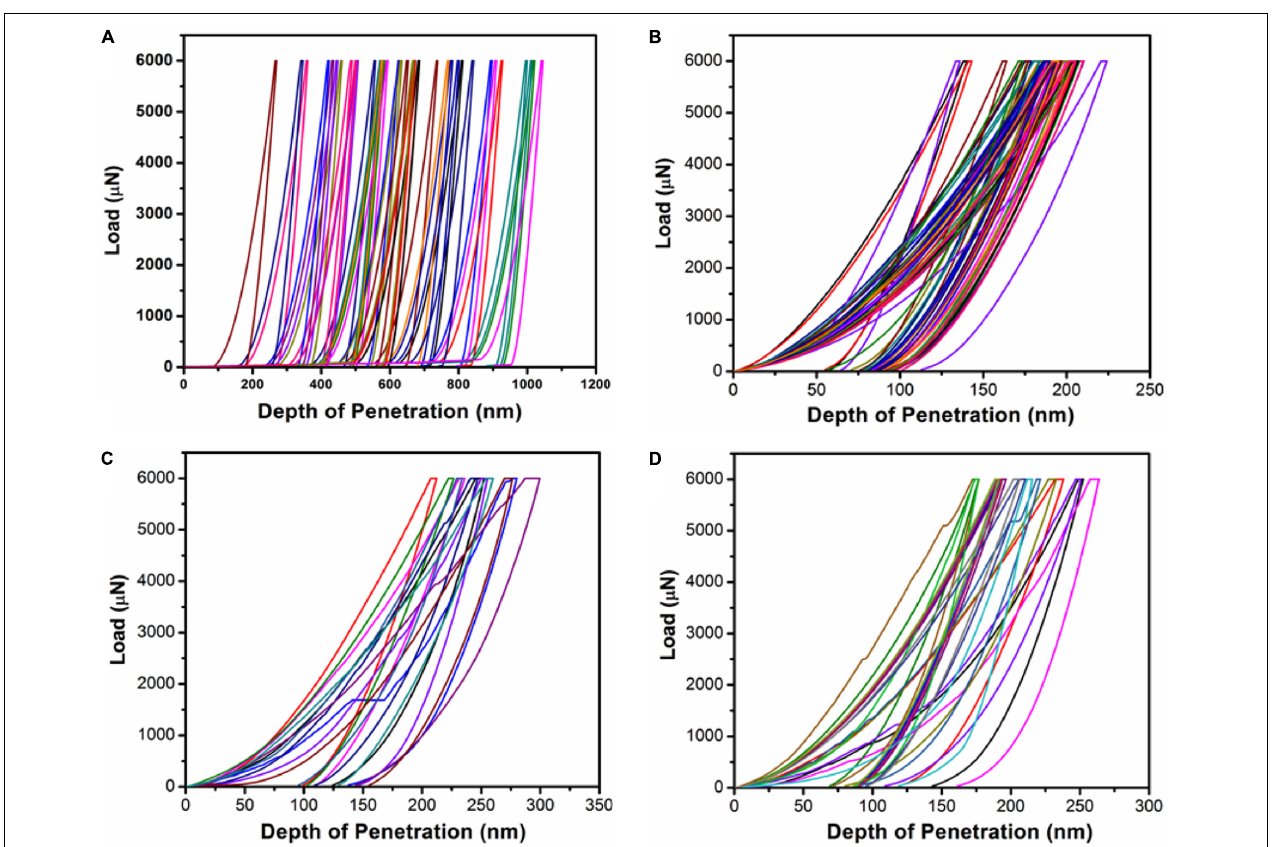
FIGURE 9 | P-h curves from nano-indentation tests using Berkovich indenter tip from K 2 O-MgO-Al 2 O 3 -B 2 O 3 -SiO 2 -F glasses with and without K 2 Cr 2 O 7 ; (a) Cr-0, (b) Cr-2, (c) Cr-4, and (d) Cr-7.